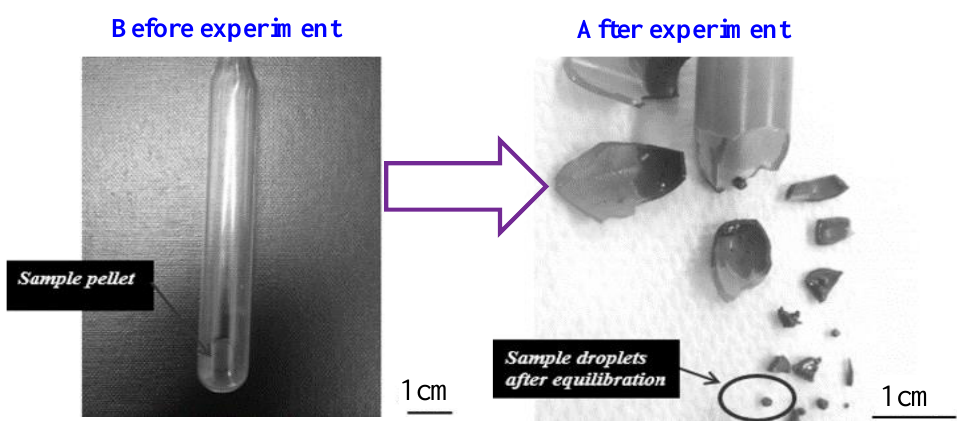
Figure 2. Closed-system equilibration used to study the slag–matte–lead–tridymite equilibrium in the Pb-Fe-O-S-Si system.